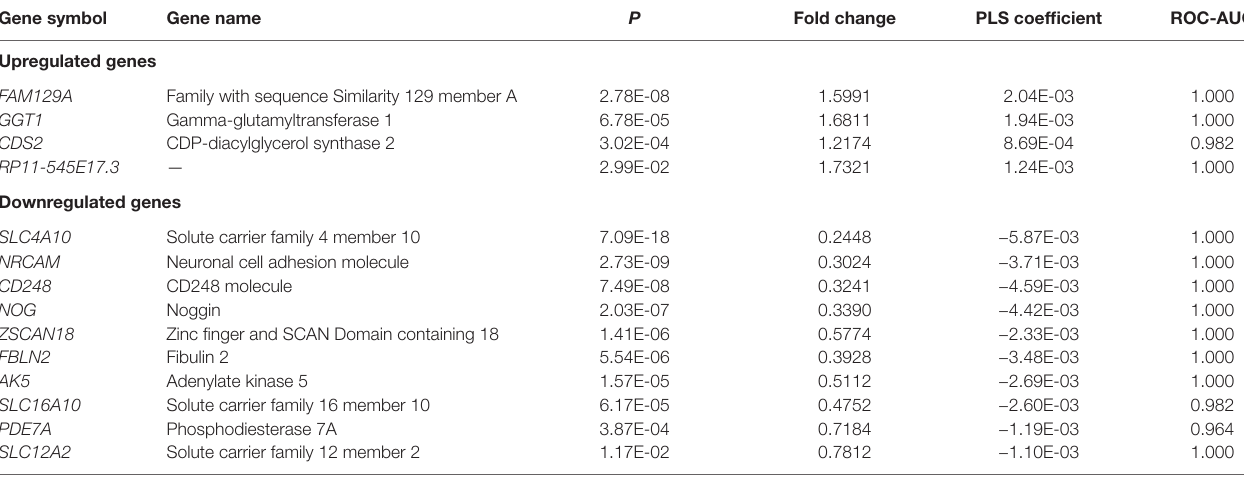
TABLE 3 | Set of 14 differentially expressed genes with P < 0.05 (from DESeq2 analysis) and with significance confirmed by UVE-PLS genes in patients with LEAD, in comparison with non-LEAD